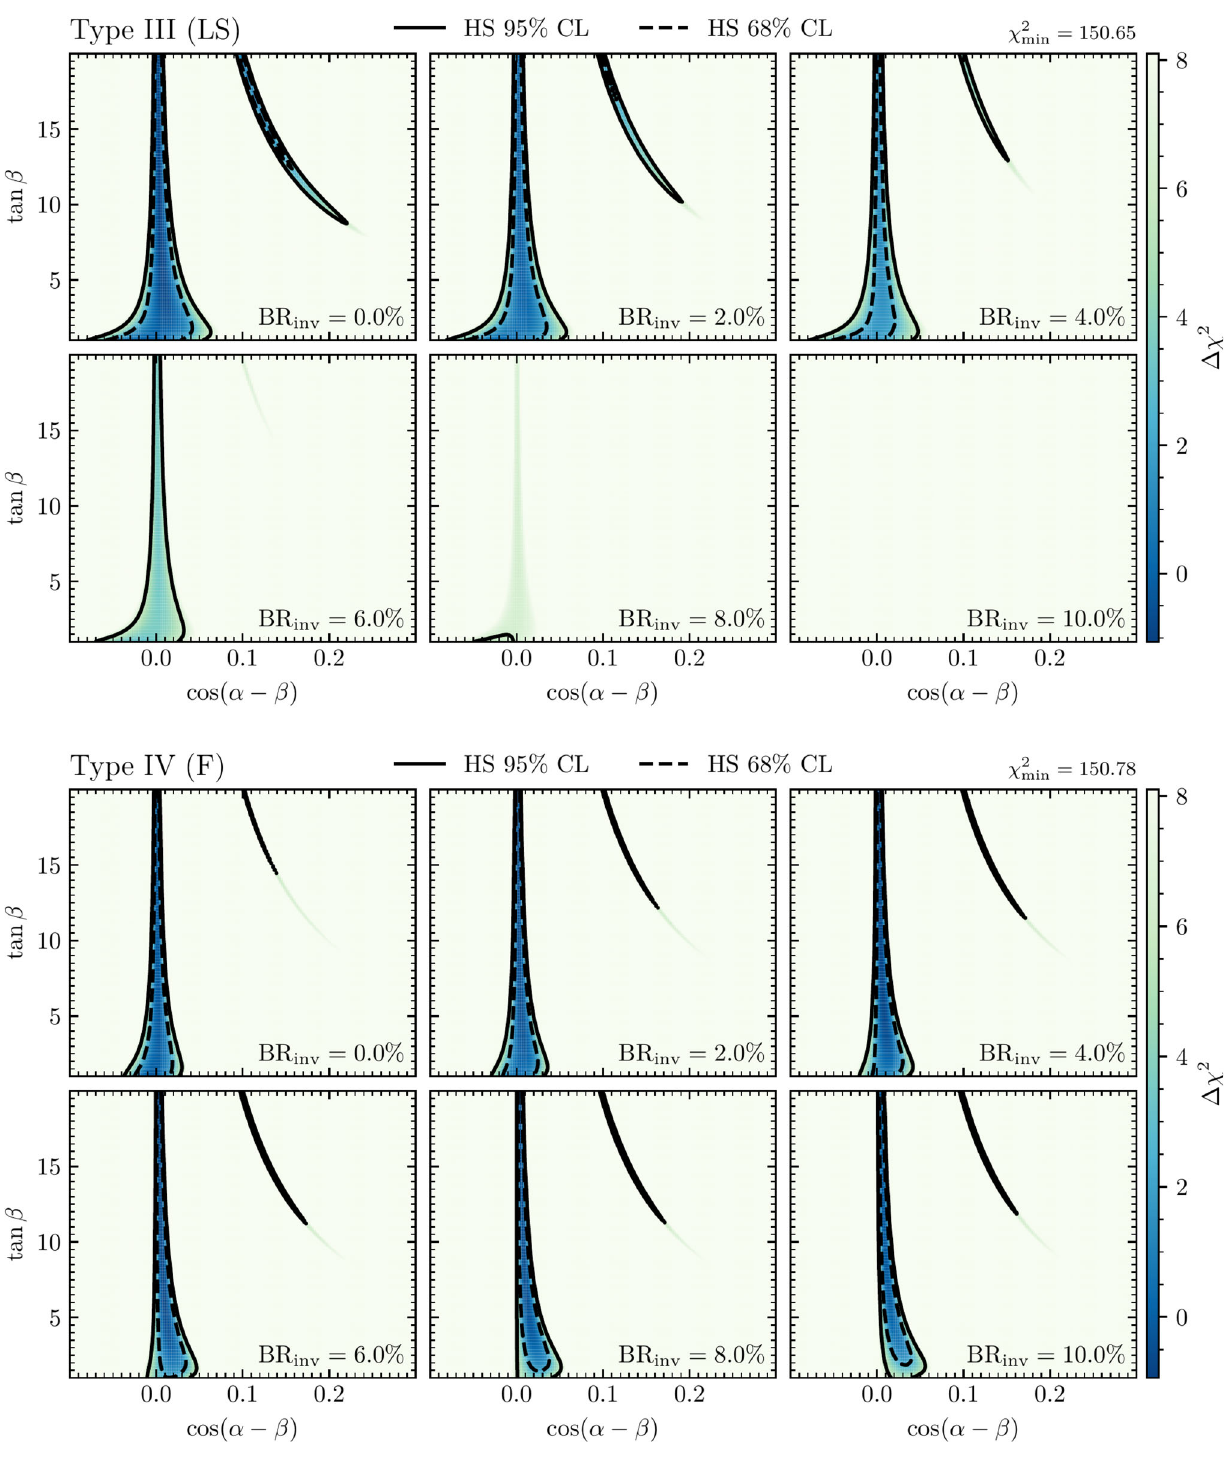
Fig. 11 Same as in Fig. 10, but for the type III (top) and the type IV